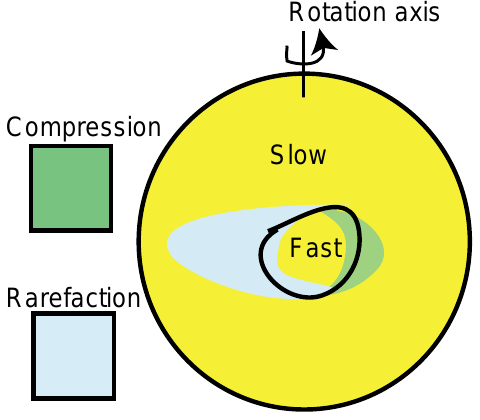
Fig. 7. Schematic of formation and orientation of streams at solar